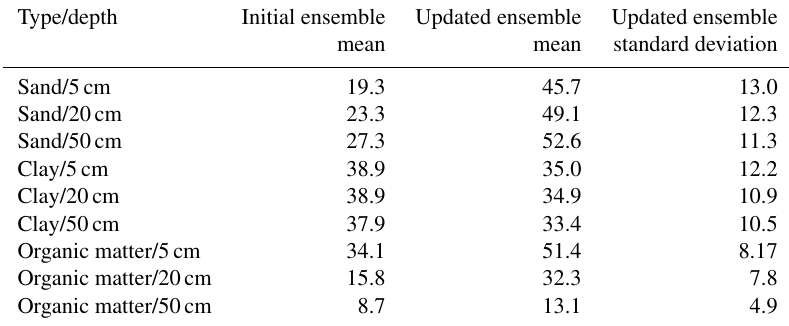
Figure 6. Correlation diagrams for observed (OBS) and simulated soil water content (SWC) at 50cm depth. Each marker shows one daily average. Panel (a) shows open loop (OL), panel (b) shows data assimilation of state variable (DA_s), panel (c) shows data assimilation of state and parameters (DA_s + p), and panel (d) shows data assimilation of state and parameters including organic matter (DA_s + p + o). Each diagram shows root mean square error (RMSE), unbiased root mean square error (ubRMSE), mean bias error (MBE), and squared correlation coefficient ( R 2 ). Table 3. Initial soil texture data and soil texture data after updating by data